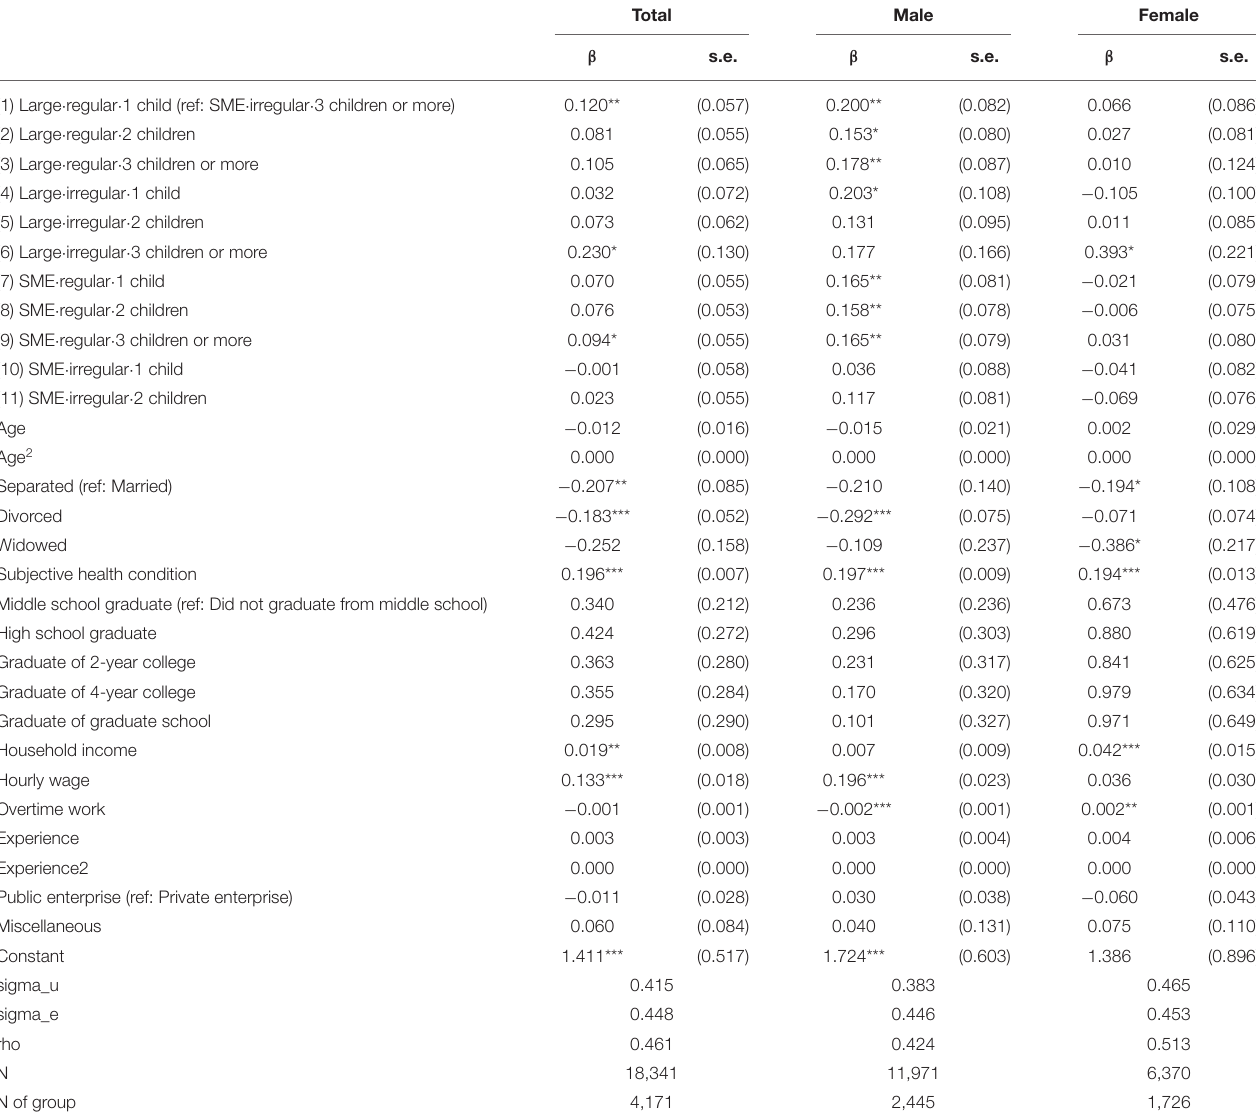
TABLE 4 | Effect of the number of children on life satisfaction by stratified labor market group